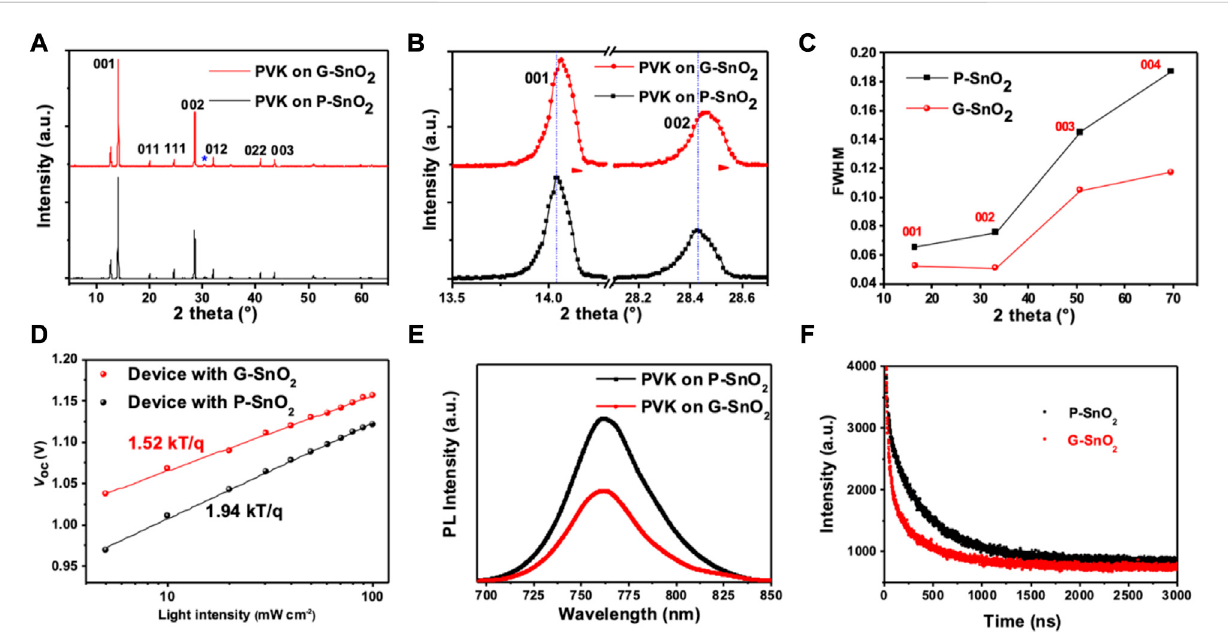
FIGURE 4 (A, B) XRD diffraction patterns of perovskite fi lms prepared on P-/G-SnO 2 layer (PVK: perovskite). (C) Evolution of the width (FWHM) of the (00l) perovskite diffraction peaks. (D) V OC as a function of the incident light intensity of devices based on P-/G-SnO 2 ETL substrates. (E) steady-state photoluminescence (PL) spectra; (F) PL decay curves of the perovskite fi lm deposited on P-/G-SnO 2